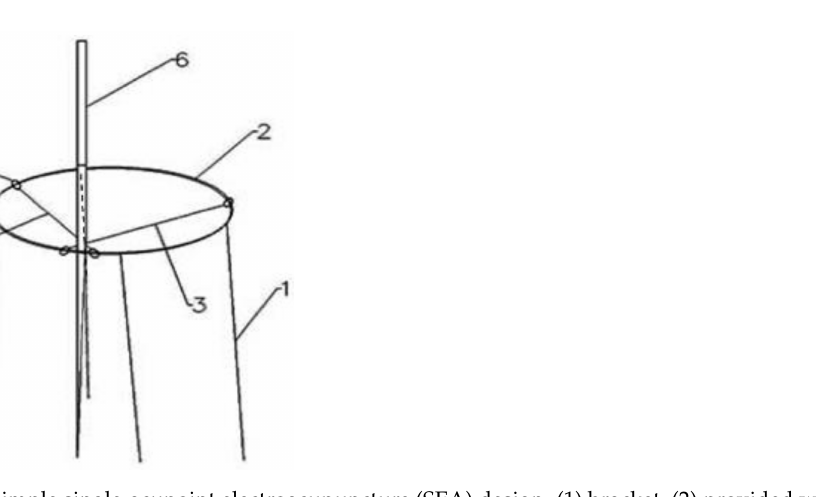
Figure 1. Simple single-acupoint electroacupuncture (SEA) design. (1) bracket, (2) provided with an insulating layer on the outer edge of the metal ring, (3) and (4) movable buckles, (5) slip ring of the movable buckle, and (6) acupuncture